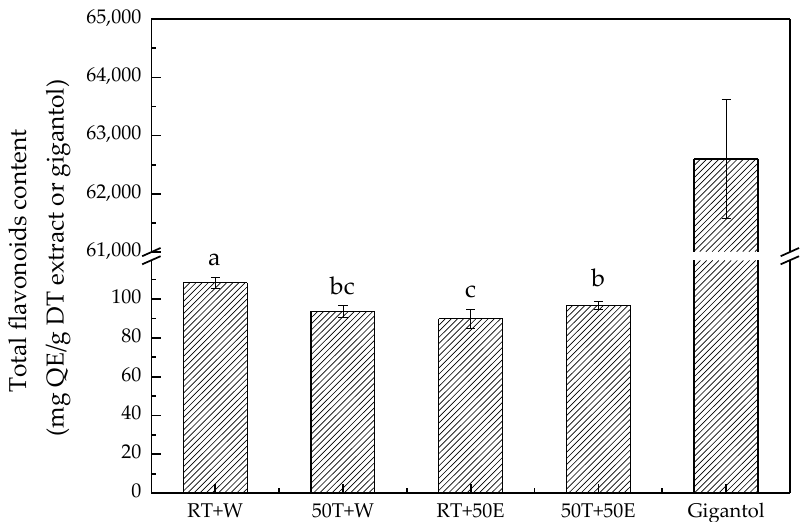
Figure 3. Total flavonoid content for the four extracts and gigantol. Treatment means with the same letter are not significantly different.